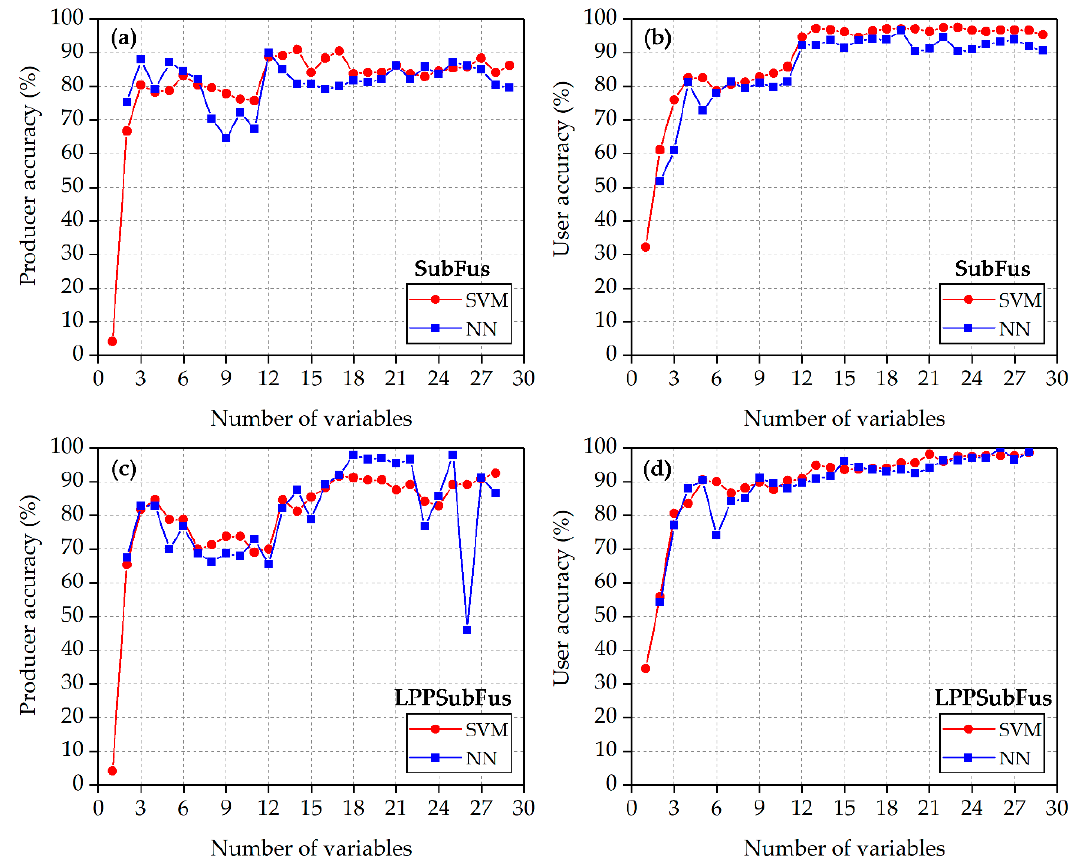
Figure 9. Producer and user accuracy curves of forests varying with the feature number using support vector machine (SVM) and neural network (NN) algorithms: ( a ) producer accuracy using subspace fusion (SubFus), ( b ) user accuracy using SubFus, ( c ) producer accuracy using locality preservation projection and subspace fusion (LPPSubFus), and ( d ) user accuracy using LPPSubFus.